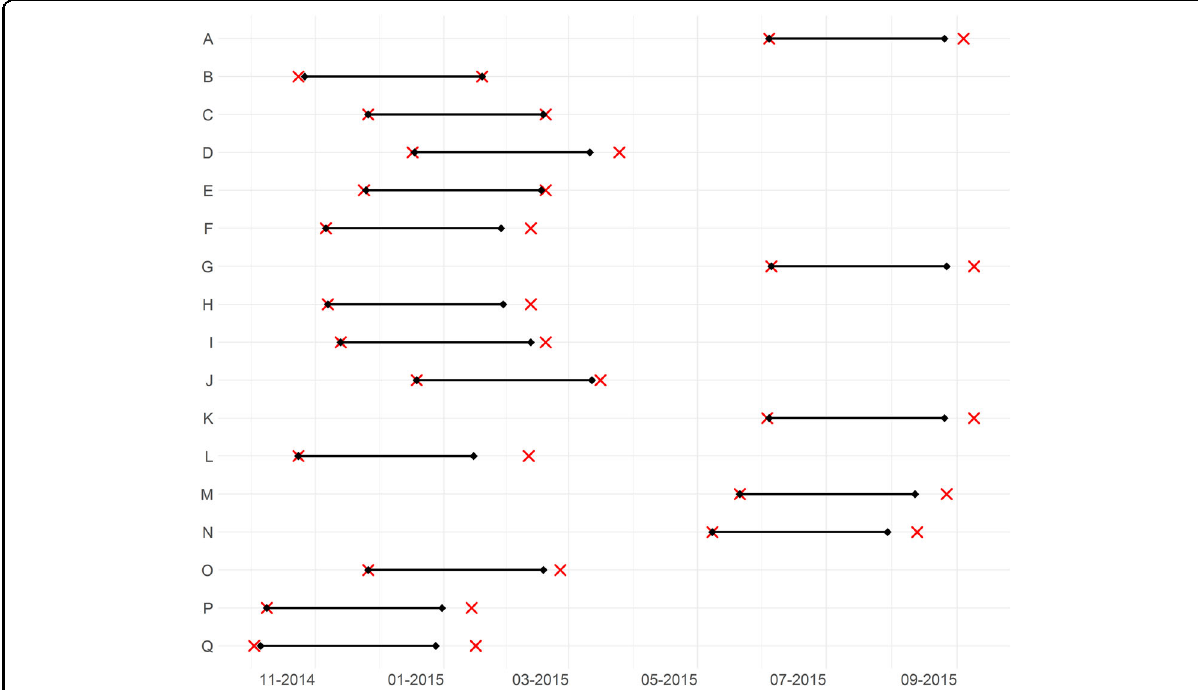
Fig. 1 Timelines for study participation of all MDD patients. Dates for initiation and completion of cognitive behavioral therapy (black diamonds connected with horizontal line), and PET1 and PET2 (red crosses). One row per patient, letters corresponding to Fig.